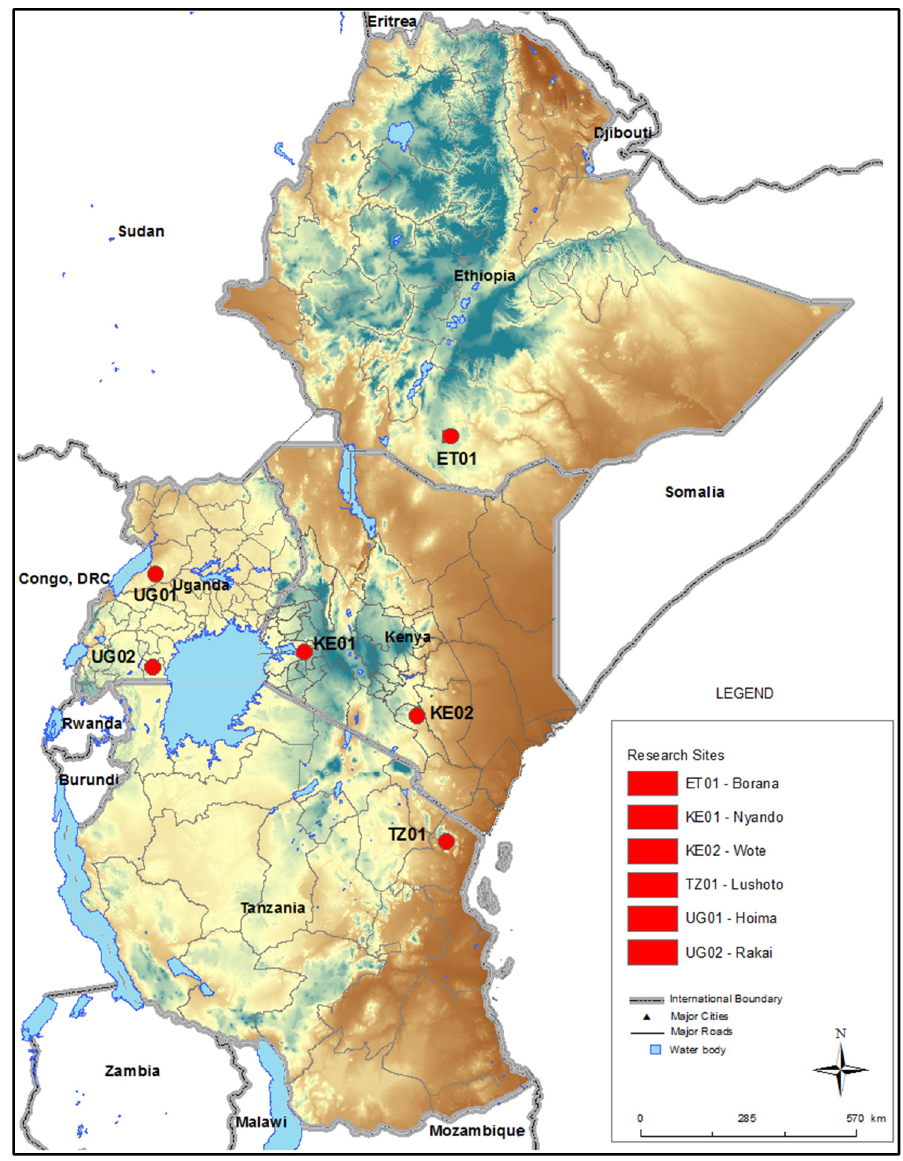
Figure 1. Location of study site.